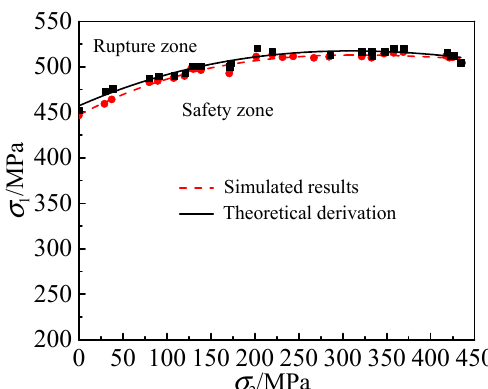
Figure 12. Comparison of FLSD of TA1 between simulated and theoretical derivation.